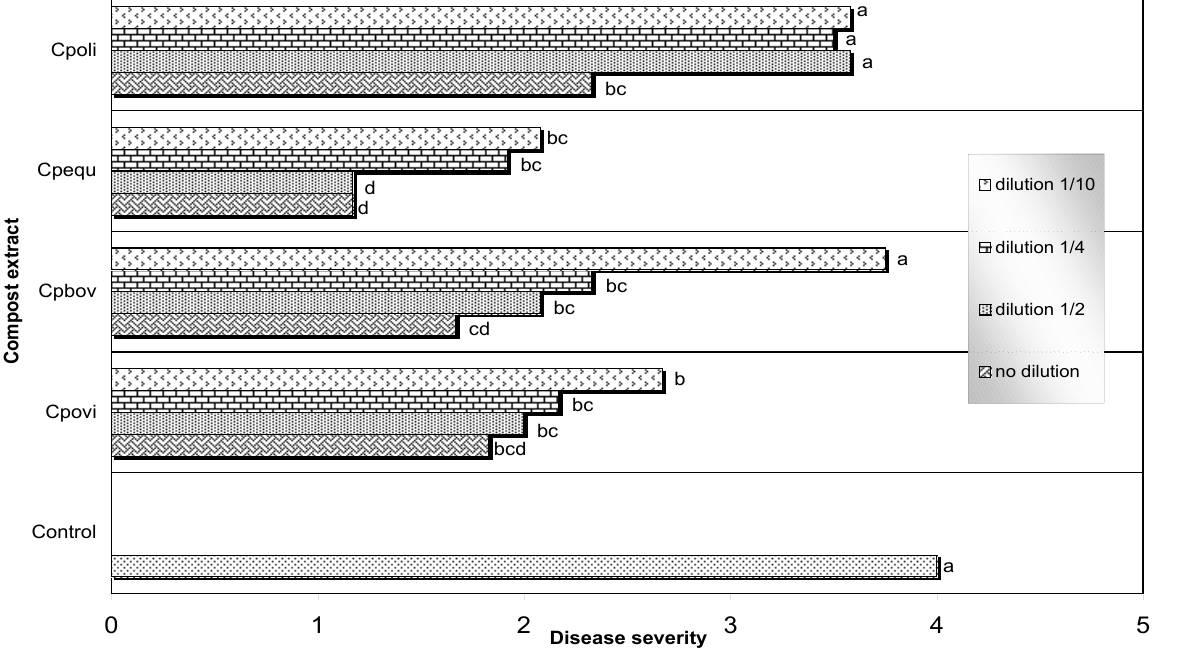
Fig. 3. Effect of dilution on compost extract effectiveness against Botrytis cinerea on tomato plants. Controls were sprayed with tap water before inoculation with B. cinerea . For disease scale and statistical analysis of data see caption in Fig.